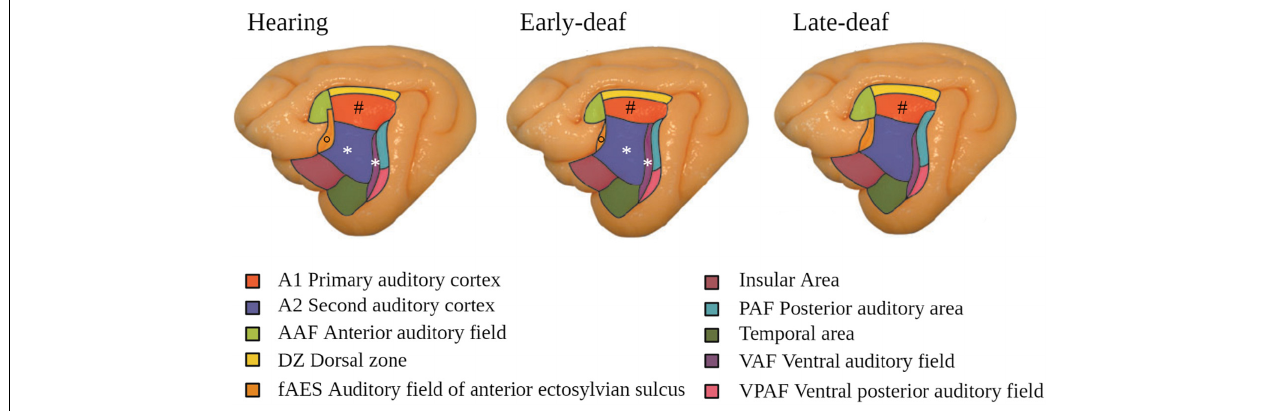
FIGURE 3 | Modifications in the auditory cortex in early- and late-deaf cats. Cytoarchitectonic study showing that A1 is reduced in both early- and late-deaf cats (#) compared to hearing cats. Additionally, in early-deaf cats, A2 and VAF are larger ( ∗ ), whereas fAES is smaller compared to normal hearing cats ( ◦ ). Data adapted from Wong et al. (2014) with permission of the author and